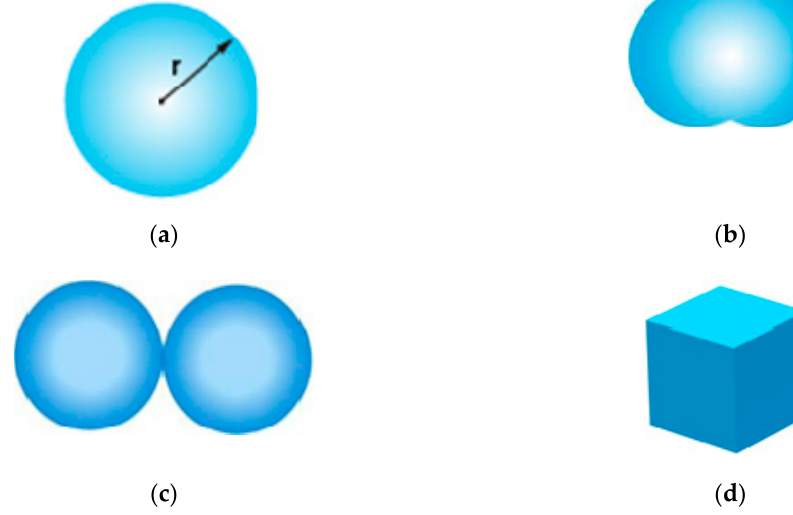
Figure 3. Models of a single charged defect with different forms of charge distribution. ( a ) is form of defect in basic state; ( b ) and ( c ) are forms of defect in excited state; ( d ) is simple cell form of the